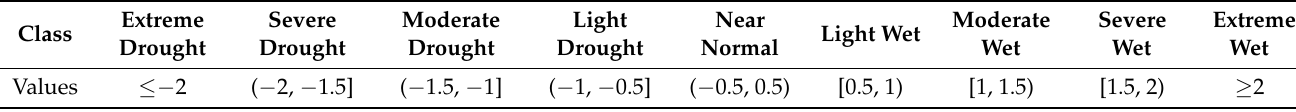
Table 2. Drought classification based on SPEI